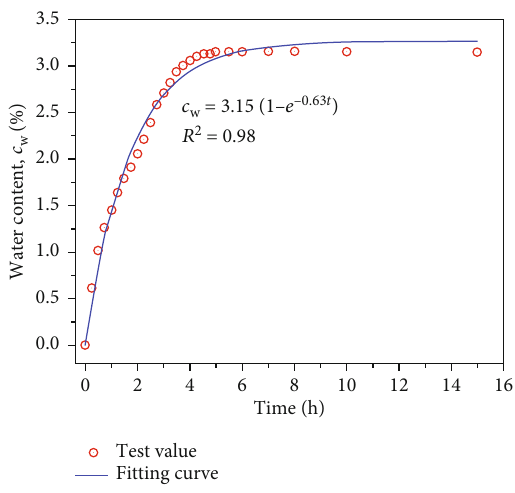
Figure 2: Water absorption process of sandstone.